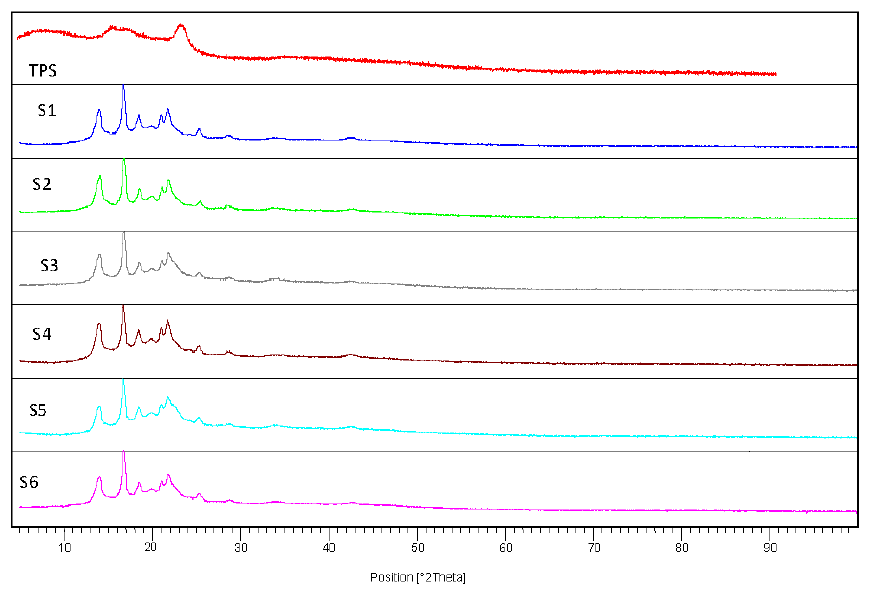
Fig. 6. X-ray Diffractograms of PP, TPS and PP/PP-AM/TPS/filler